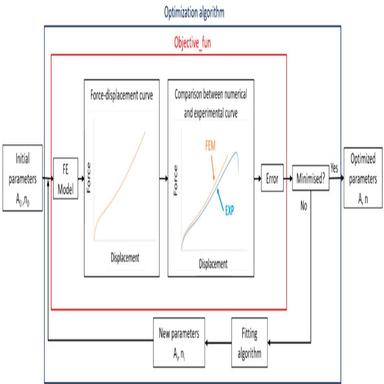
Inverse analysis algorithm.